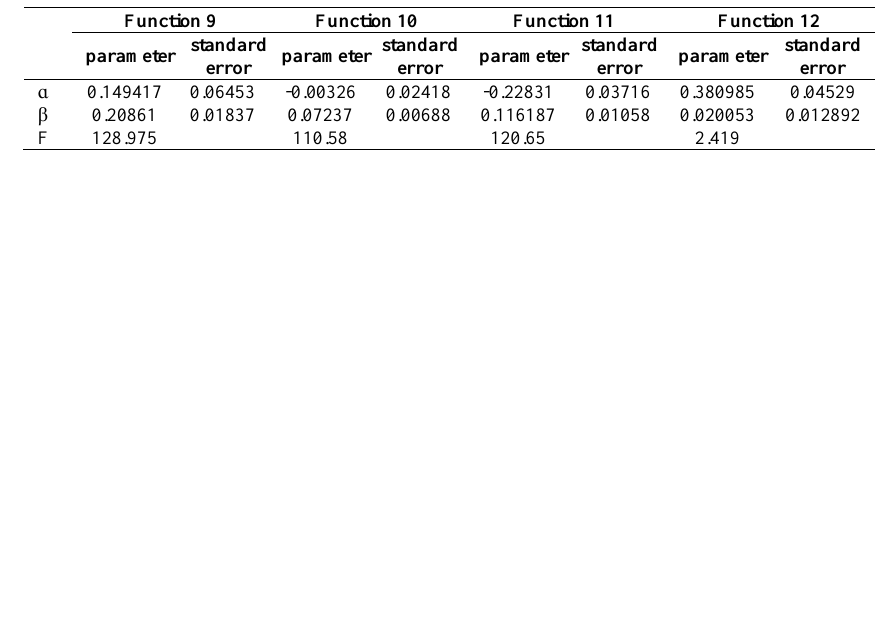
Table 6. Results of modeling for connection “size of spending – its entropy”